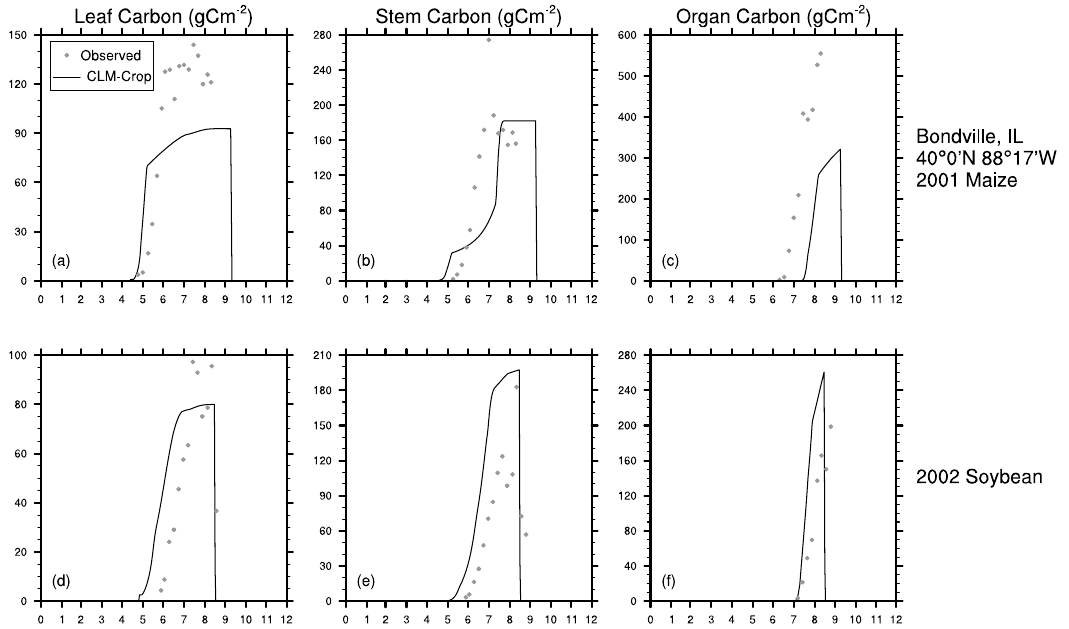
Fig. 4. Simulated (lines) and observed (circles) leaf, stem, and organ carbon (g C m − 2 ) during 2001 and 2002 for maize and soybean at Bondville,